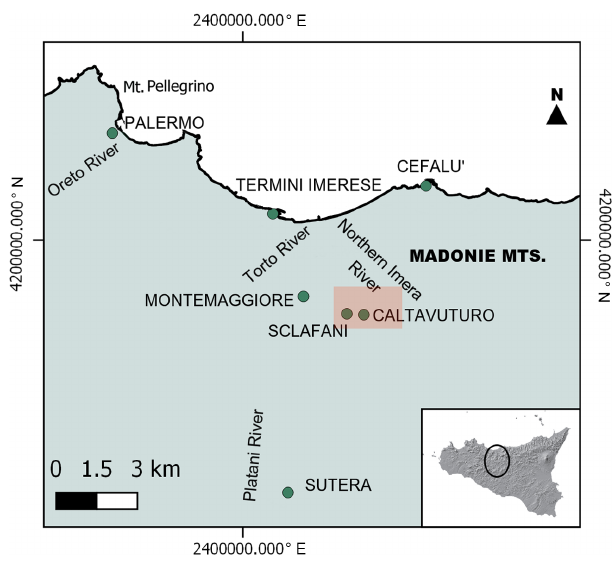
Figure 1. Map of Sicily with the location of the study area and of the sites cited in the text. Map Datum World Geodetic System 1984/Universal Transverse of Mercator Zone 32 ◦